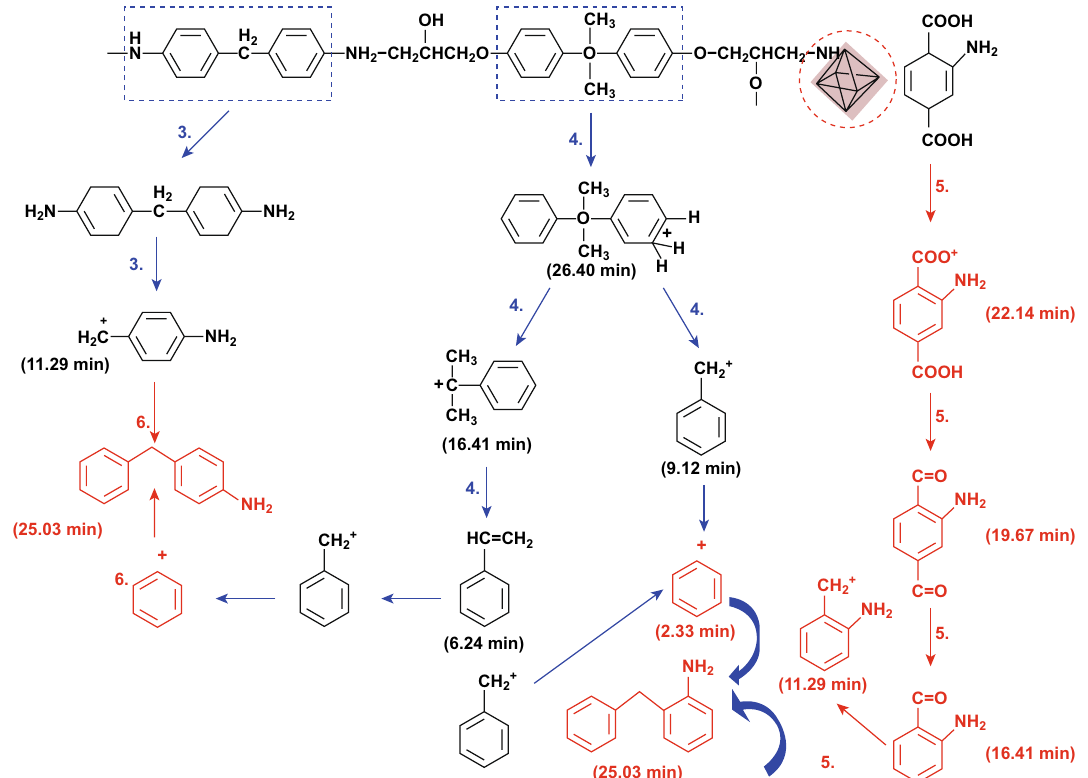
Fig. 12 The new pyrolysis route of the EP composites with the addition of 5 wt% PA modified UiO66‑NH 2 sample. Reproduced from Ref. [44] with permission from American Chemical